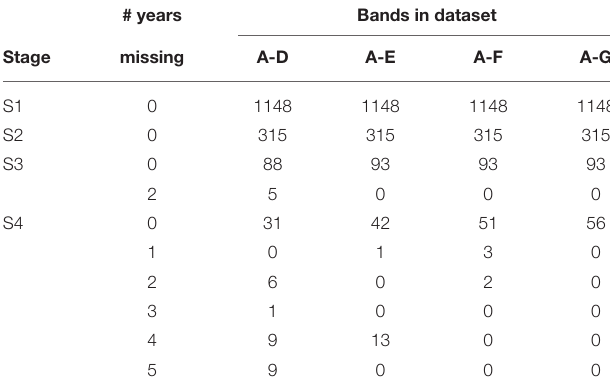
TABLE 6 | MET dataset construction for 2018 selection decisions in durum breeding program.